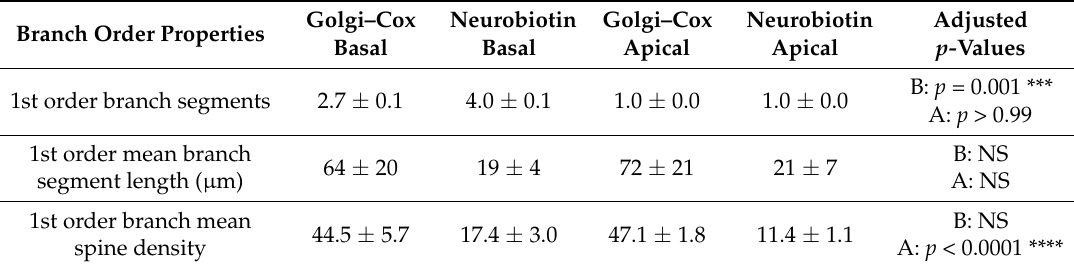
Table 3. Branch order characteristics for Golgi–Cox-stained and neurobiotin-filled BLA principal cells. All data presented as mean ±